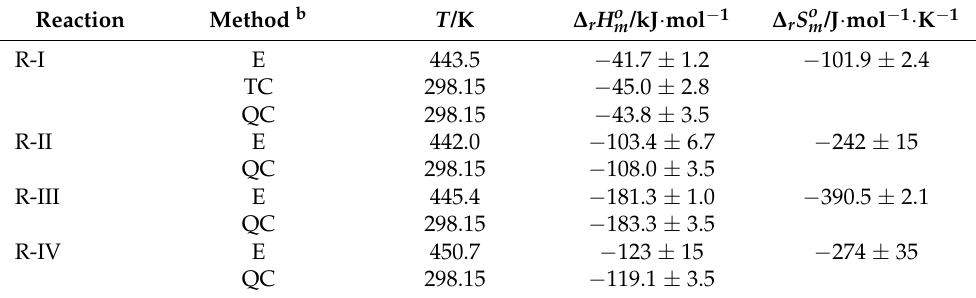
Table 2. Thermodynamic values of the liquid-phase hydrogenation reactions R-I to R-IV in the